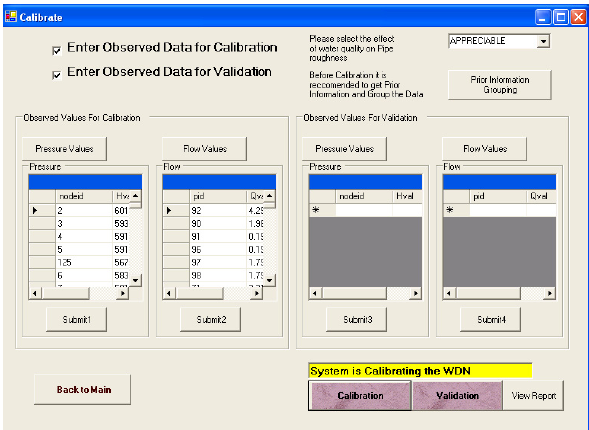
Fig. 13. Calibration result for Vasant Vihar WDN